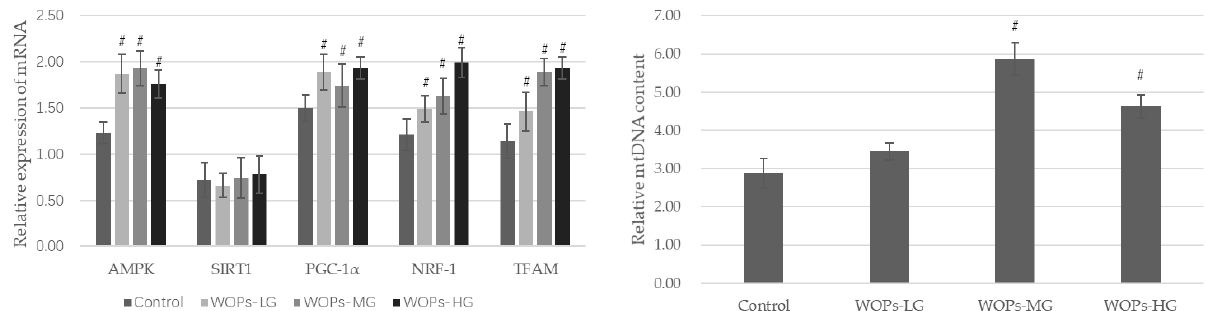
Figure 3. Effects of WOPs on the RNA expression of AMPK, SIRT1, PGC-1 α , NRF-1, TFAM, and relative mtDNA content in gastrocnemius by real-time PCR analysis. Data are expressed as mean ± SD ( n = 6 per group). # p < 0.05 vs. Control. Control, SAMP8 age control group; WOPs-LG, SAMP8- WOPs-LG at a dose of 110 mg/kg·bw; WOPs-MG, SAMP8-WOPs-MG at a dose of 220 mg/kg·bw; WOPs-HG, SAMP8-WOPs-HG at a dose of 440 mg/kg·bw.